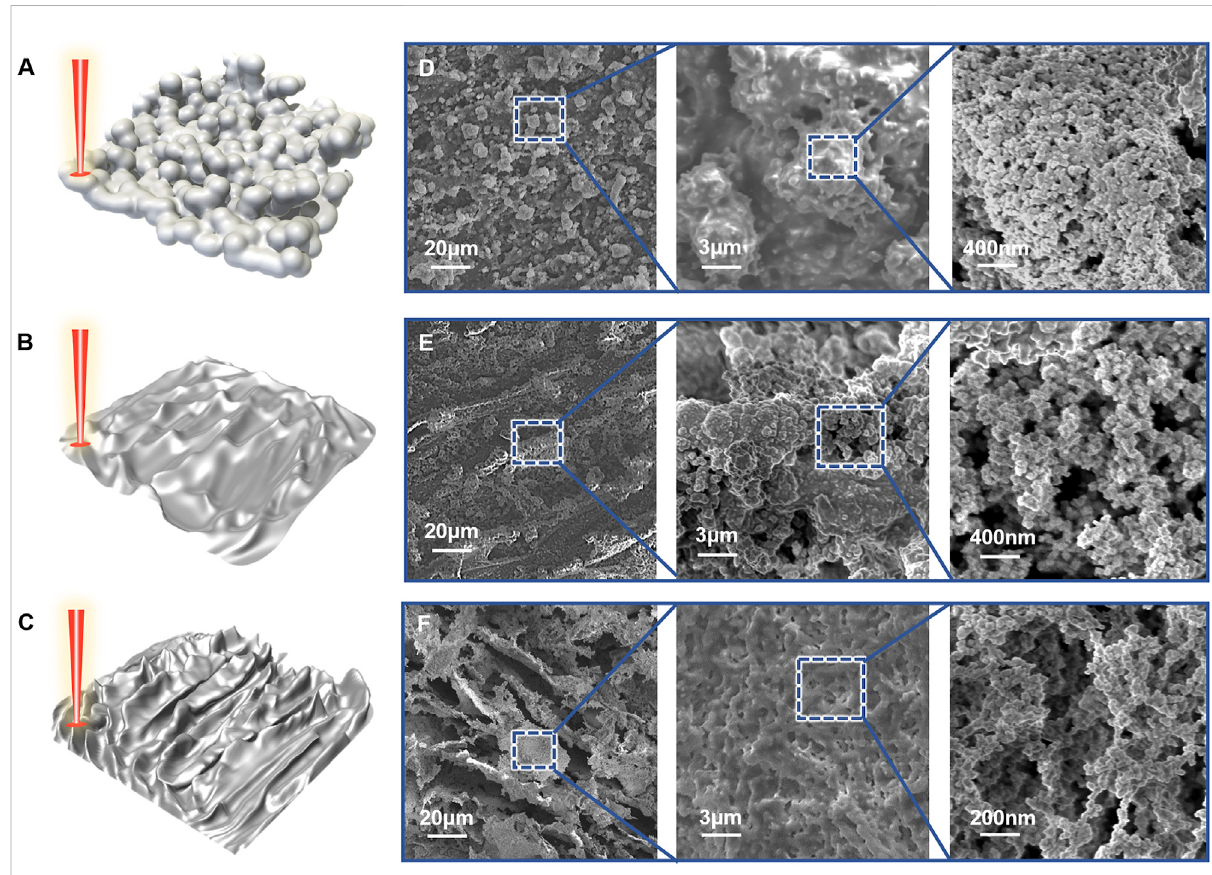
FIGURE 4 (A) Schematicviewofsuperhydrophobicsurfacestructure. (B) Schematicviewofthesurfacestructureofthetransitionfromsuperhydrophobic to superhydrophilic. (C) Schematic diagram of super hydrophilic structure surface structure. (D,E,F) Irregular micro-nanostructure by laser etching. SEM images with different magni fi cations E of intermediate state, F of superhydrophilic surface, Scale bars are